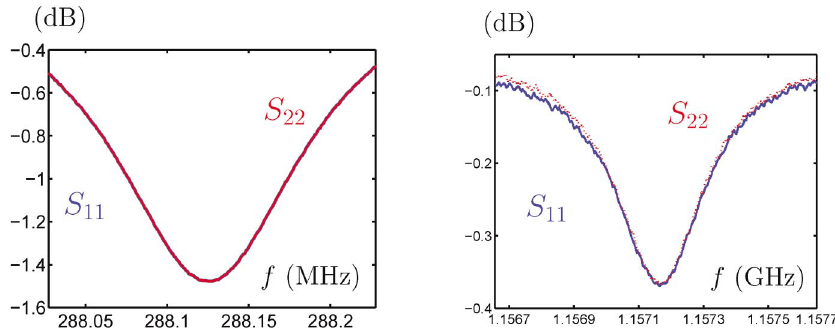
FIG. 13. (Color) S (blue solid line) and S (red dashed line) for a typical Q -factor measurement at the two resonant 11 22